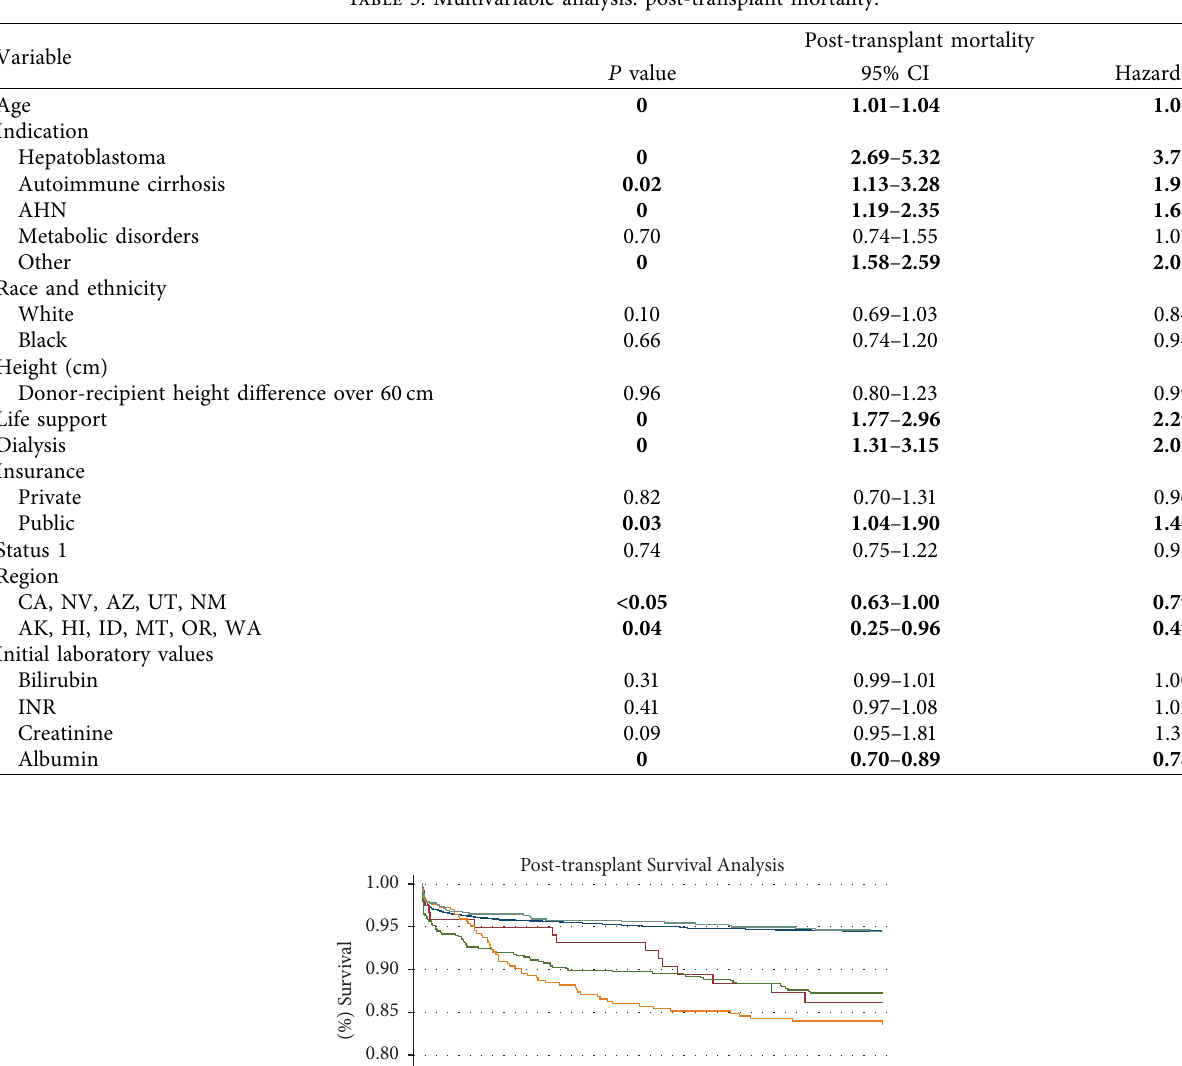
Table 5: Multivariable analysis: post-transplant mortality.